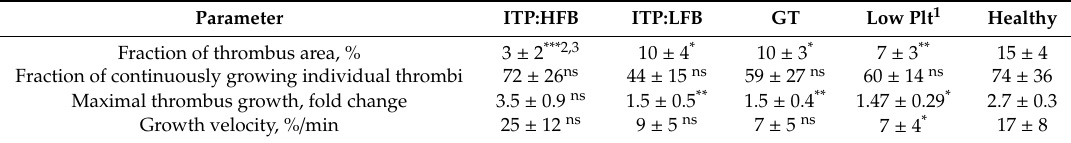
Table 1. Parameters of ex vivo thrombus growth after 20 min of the experiment.